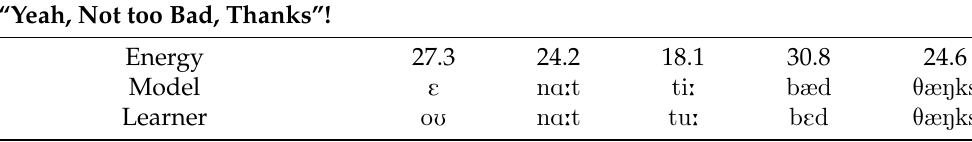
Table 1. Transcription and energy for task 8 lesson